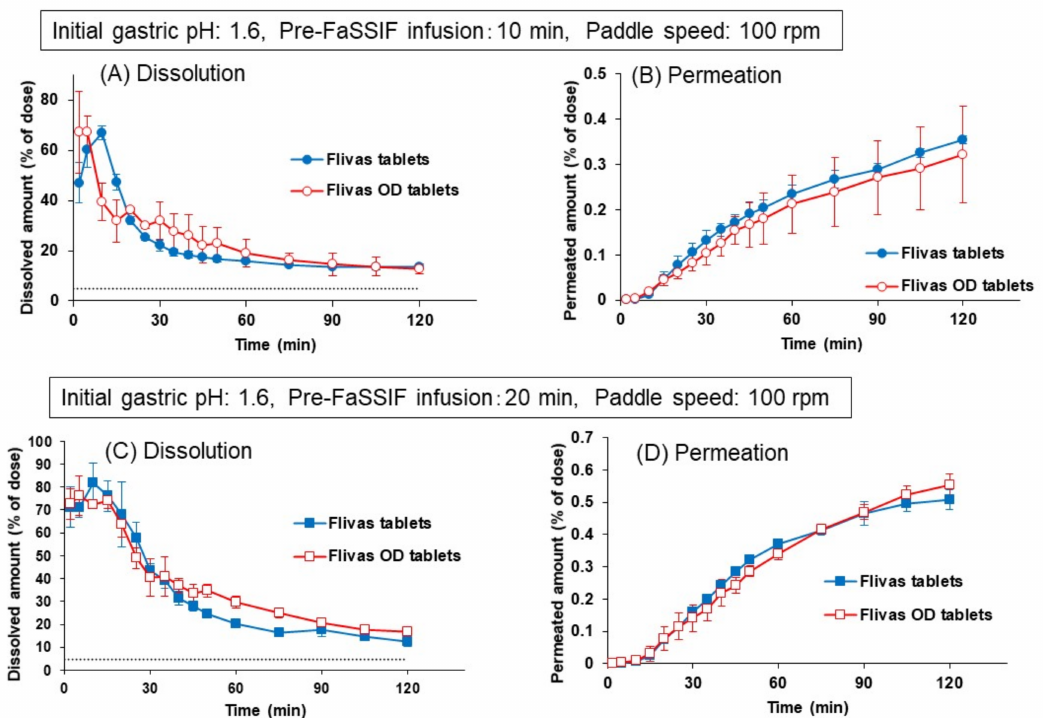
Figure 10. Comparison of dissolution ( A , C ) and permeation ( B , D ) of naftopidil from Flivas ® tablets and Flivas ® OD tablets in the BE checker. Experiments were performed with a new experimental protocol with 1-min disintegration time. Pre-FaSSIF infusion time was set to 10 min ( A , B ) or to 20 min ( C , D ). Initial FaSSGF pH was 1.6, and paddle speed was 100 rpm. Each data point represents mean ± S.D. ( n =